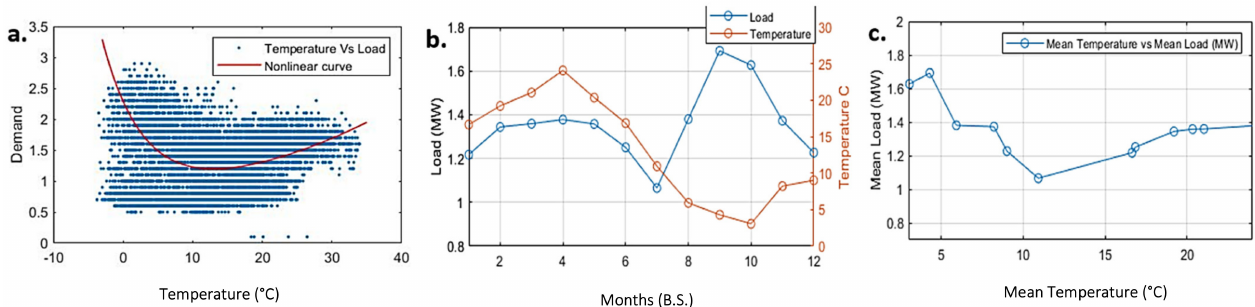
Figure 5. ( a ) Joint plot of the electric load vs. temperature. ( b ) Monthly mean plot of the electric load and temperature. ( c ) Mean plot of the temperature vs. electric